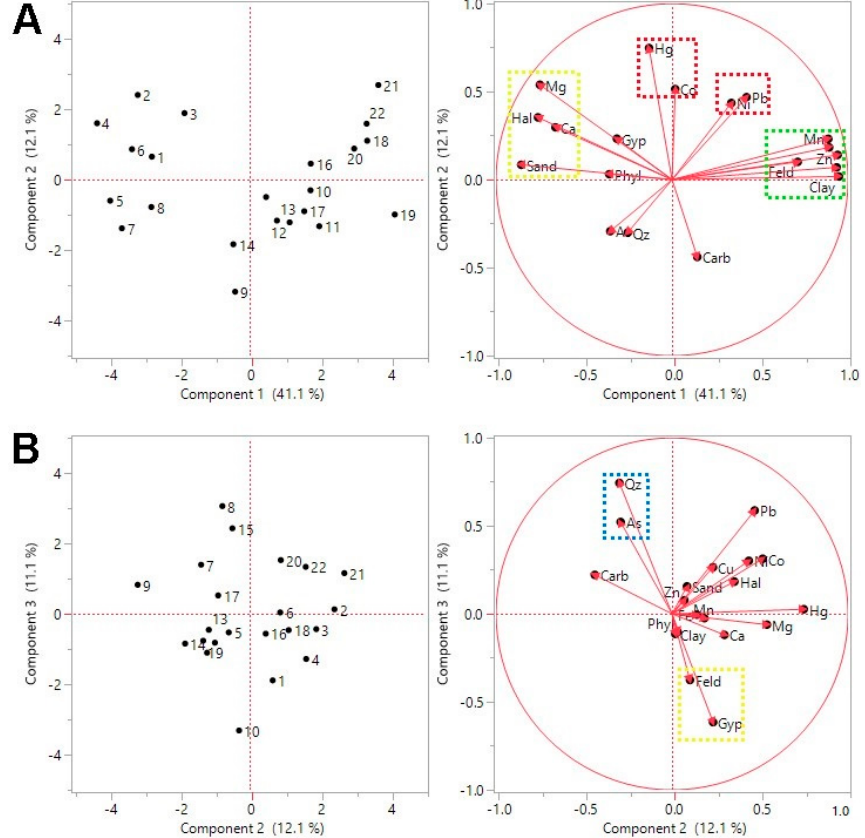
Figure 5. Maps of the principal components for geochemical, grain-size and mineralogical variables. ( A ) The vector loadings for the two main components of the Principal Component Analysis (PCA) define two perpendicular links, indicating two independent controls on the data. The first link connects elements assumed to be carried with fine-grained detrital minerals in opposition to elements that may result from precipitation in the lagoon. The second link connects a set of elements that may have anthropogenic sources. ( B ) The plot of PC2 vs. PC3 shows the opposition of quartz and feldspar, two detrital minerals whose relative enrichment in the lagoon sediments can be attributed to specific source areas. Gypsum seems to be associated with feldspar, which is compatible with a source in Meso-Cenozoic units of the neighboring Cuanza